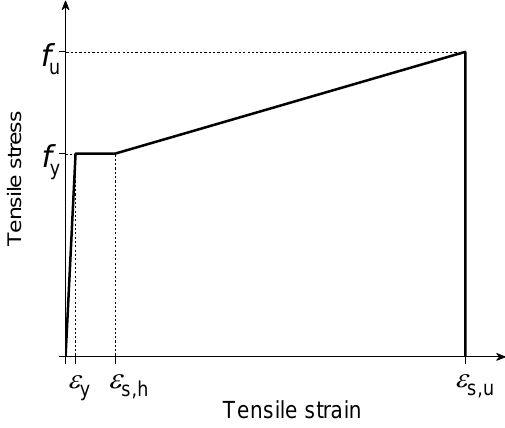
Figure 2. Constitutive models for steel reinforcement.